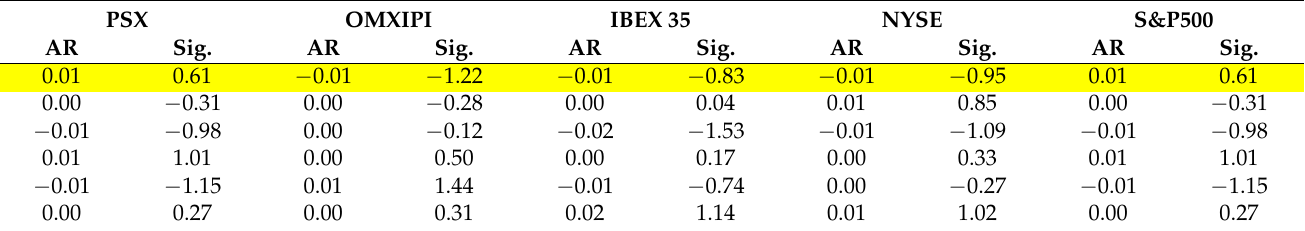
Table A4. Abnormal returns for the (0, +5) event window (News of Panama